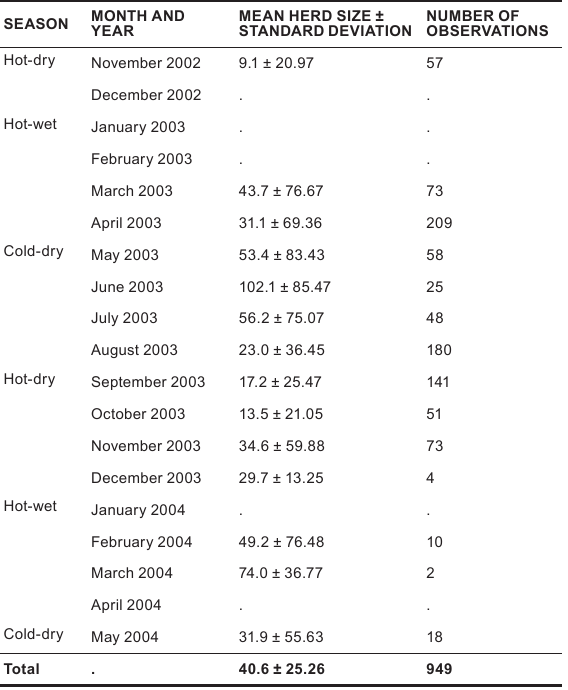
Table 3 Mean herd sizes of springbok by month for the period from November 2002 to May 2004 in the Kalahari Gemsbok National